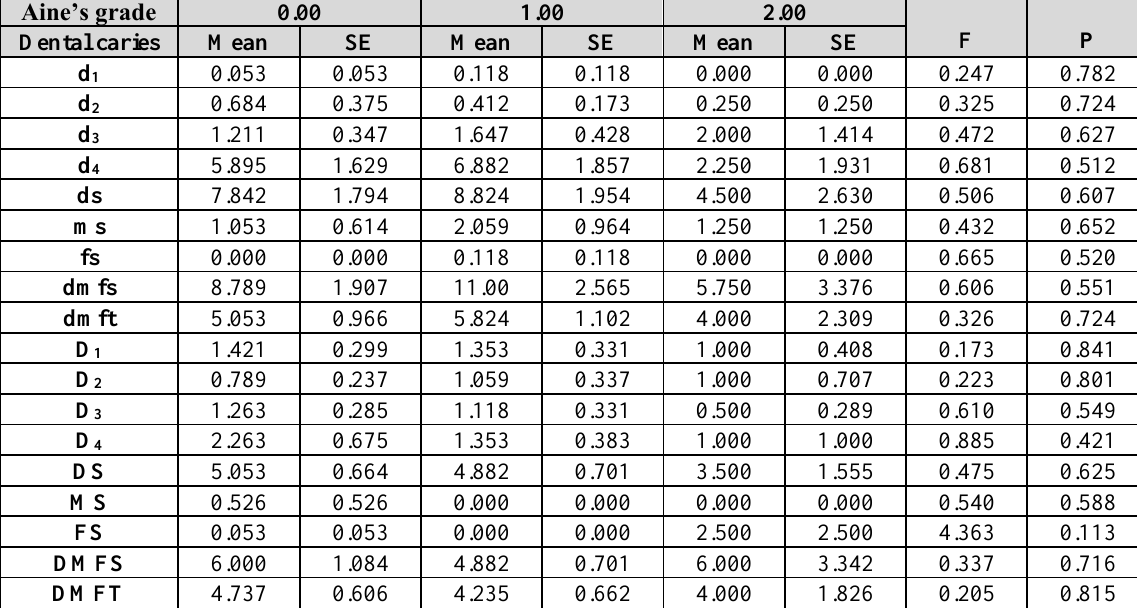
Table 5: Dental caries experience and severity in primary and permanent teeth in relation to Aine’s grades of celiac disease enamel